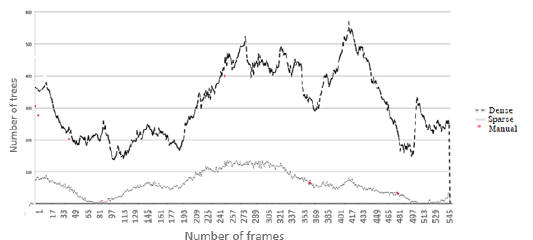
Figure 16 Graph Depicting Number of Trees Vs Number of